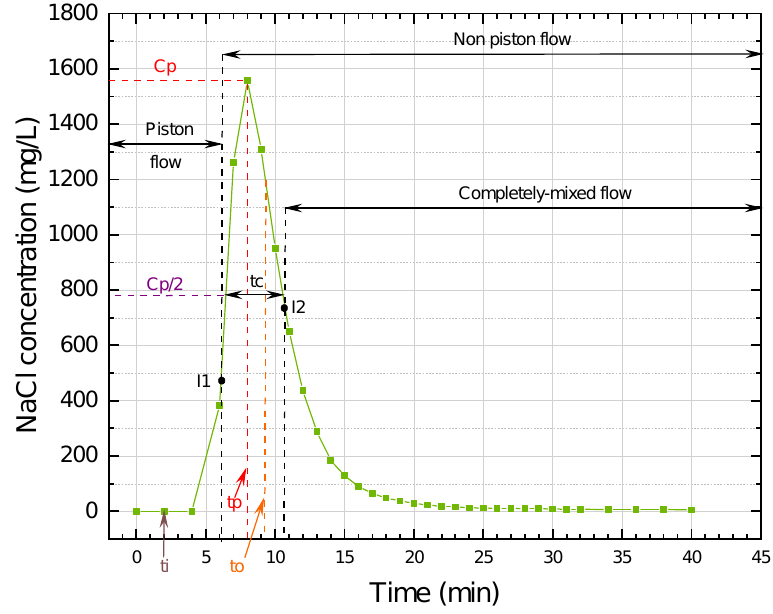
Figure 4. Variation of tracer concentration in RSF effluent–Flow 1.0 m 3